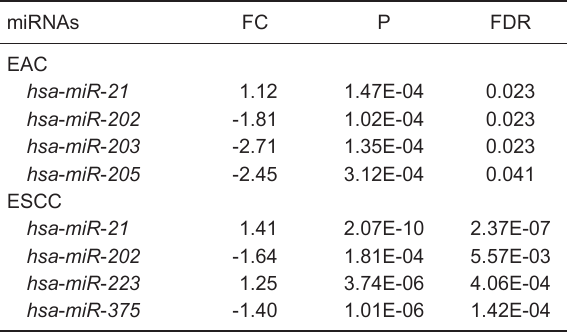
Table 1. Differentially expressed miRNAs in esophageal adeno- carcinoma (EAC) and squamous-cell carcinoma (ESCC). miRNAs